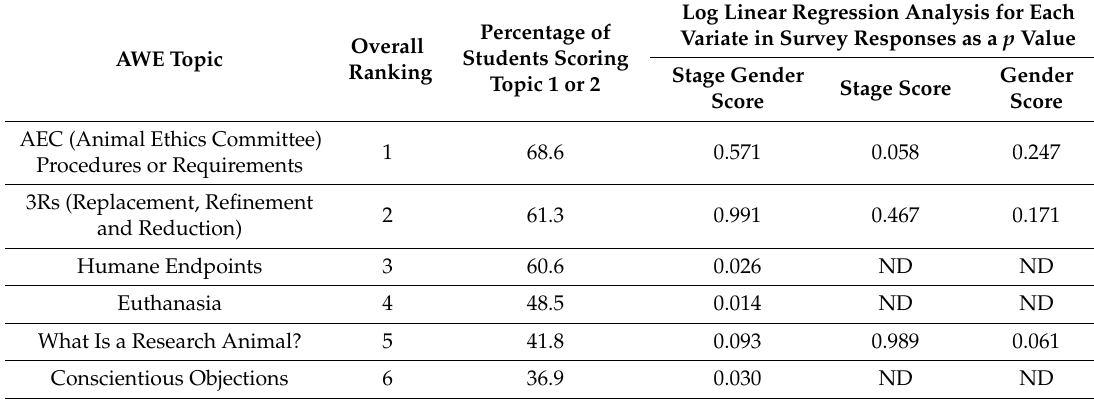
Table 2. The ranked importance assigned to the animal welfare and ethics (AWE) topics and the log-linear regression analysis related to animals kept for scientific purposes by veterinary